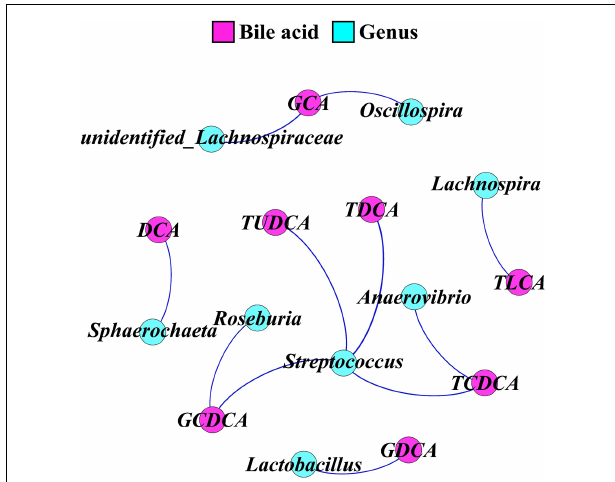
FIGURE 6 | A network for correlation analysis between the top 30 genera and fecal bile acids using relevant networking. The nodes were colored according to bile acid and genus. Only correlations with Spearman’s coefficient r > 0.5 and p < 0.05 are shown. TUDCA, tauro-ursodeoxycholic acid; TCDCA, tauro-chenodeoxycholic acid; TDCA, tauro-deoxycholic acid; GCA, glycol-cholic acid; GDCA, glycol-deoxycholic acid; TLCA, tauro-lithocholic acid; GCDCA, glycol-chenodeoxycholic acid; DCA, deoxycholic